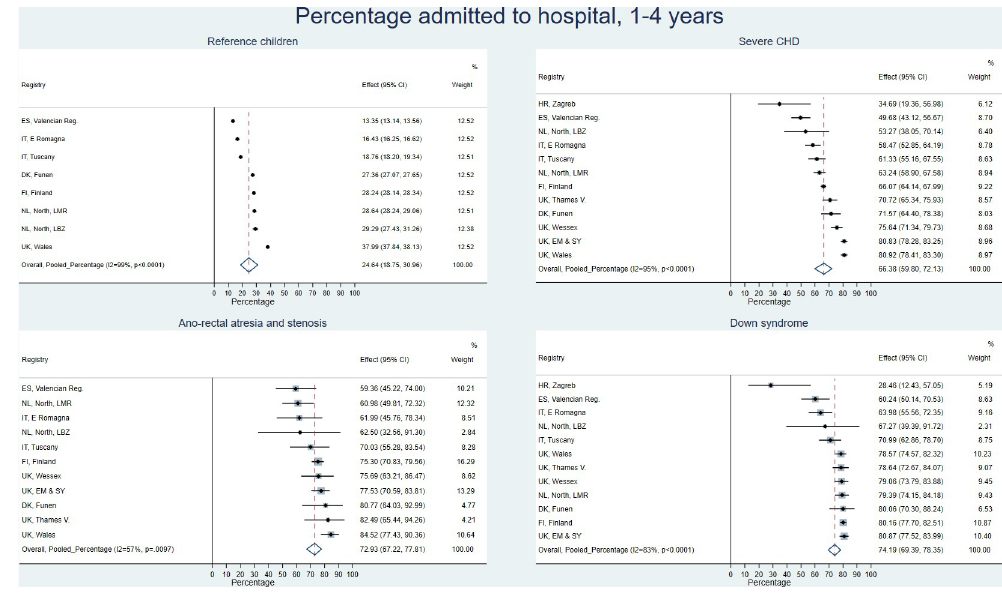
Fig 1. Meta-analysis of percentage hospitalised between 1–4 years for selected anomaly subgroups and reference children. Registry specific percentages (1-Kaplan-Meier estimate) of children ever hospitalised between 1–4 years and pooled percentage (based on 1-Kaplan-Meier estimates) estimated from meta-analysis of all available registers. Registries with < 3 cases in subgroup not included. CHD = Congenital Heart Defects. https://doi.org/10.1371/journal.pone.0269874.g001 the pooled estimated percentage was 66% (95% CI: 60–72%). There was a considerable degree of between-study heterogeneity, reflecting the differences in percentages hospitalised across registries (see S3A and S3B Table). The meta-analysis of the median LOS per year for those with at least one admission by anomaly subgroup is presented in Table 3; measures of heterogeneity and number of registers included in each meta-analysis of the median LOS can be seen in S4 Table. Overall, the median LOS for the reference children was 3.0 days (95% CI: 2.3–3.7) in the first year and 0.4 days per year (95% CI: 0.2–0.5) at ages 1–4 years. The median LOS for the EUROCAT children was 7.9 days (95% CI: 7.0–8.8) in the first year and 1.0 days per year (95% CI: 0.7–1.2) at ages 1–4 years. The median LOS in the first year for children with severe CHD was 23.7 days (95% CI: Table 3. Meta-analysis of median length of stay per year according to congenital anomaly subgroup and